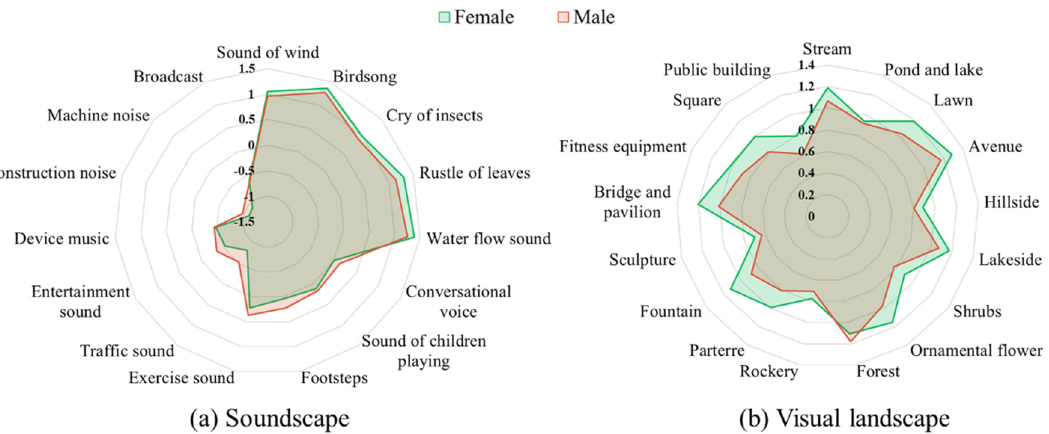
Figure 7. Radar map of soundscape ( a ) and visual landscape ( b ) preferences distribution of exercisers at different genders.